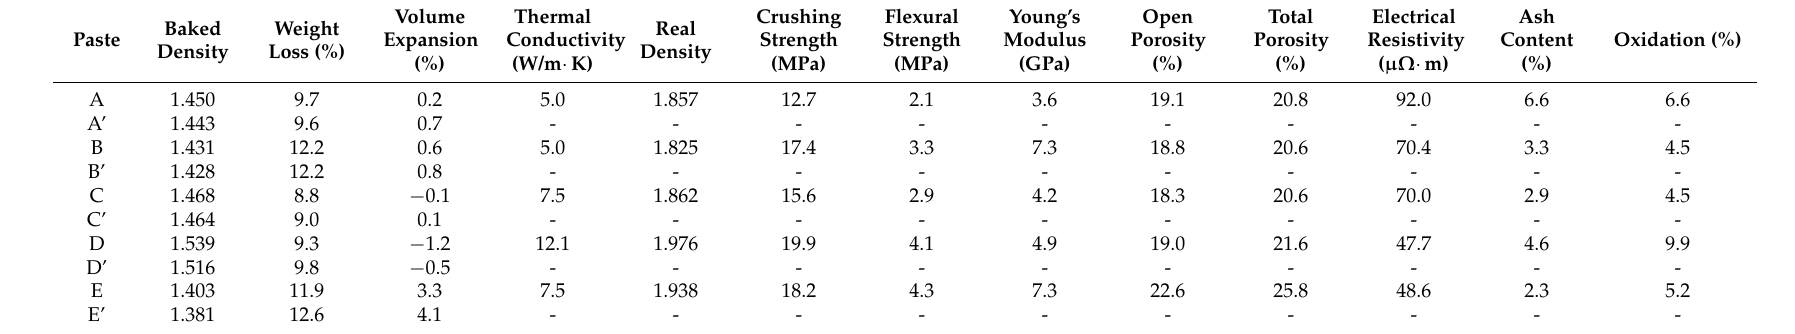
Table 7. Comparison of paste properties after